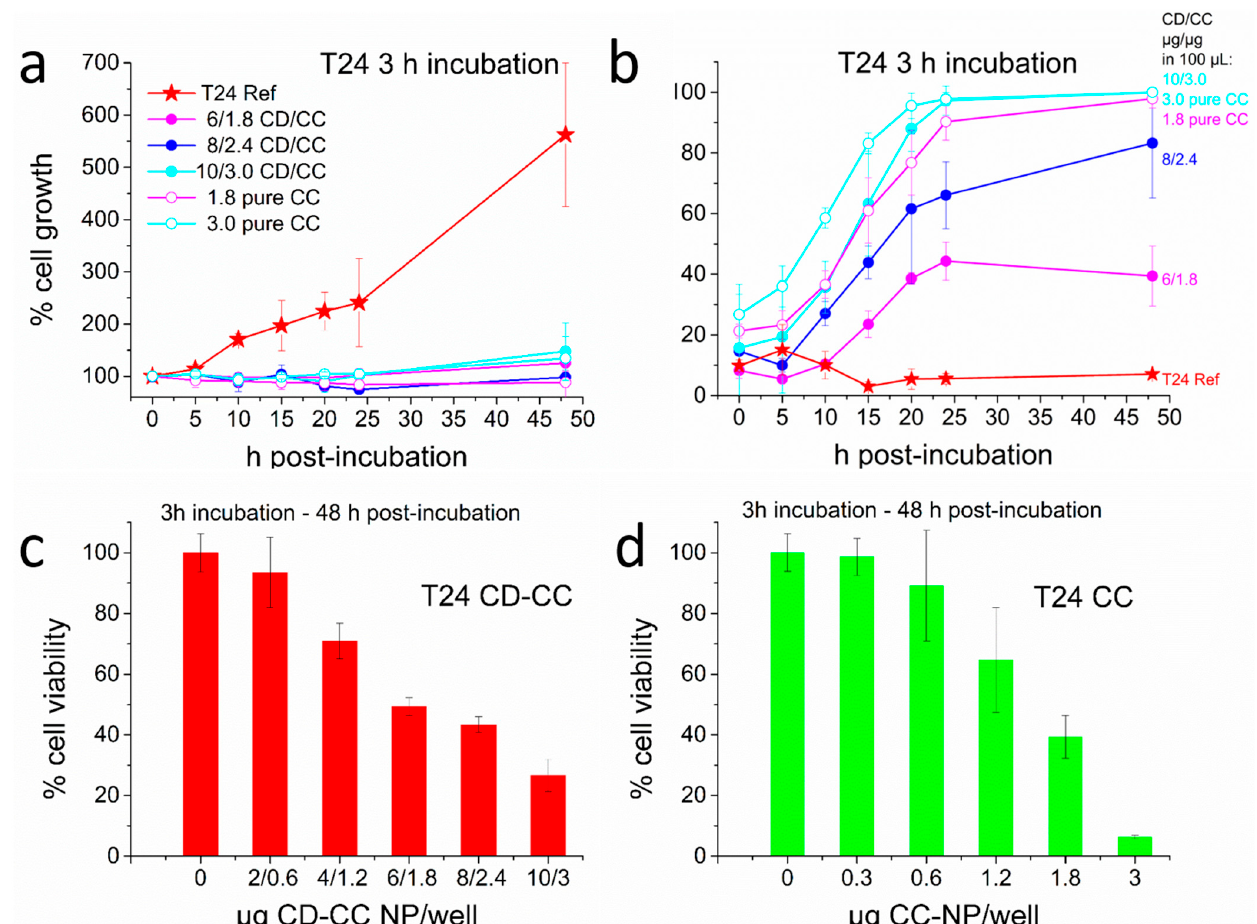
Figure 9. Effect of CC-NP and CD-CC-NP on T24 bladder cancer cells using a 3 h incubation, ( a ) proliferation histogram, ( b ) kinetic response curves displaying cell mortality, ( c , d ) corresponding CCK-8 viability assays performed after 48 h on ( c ) CD-CC-NP treated cells and ( d ) CC-NP treated cells.